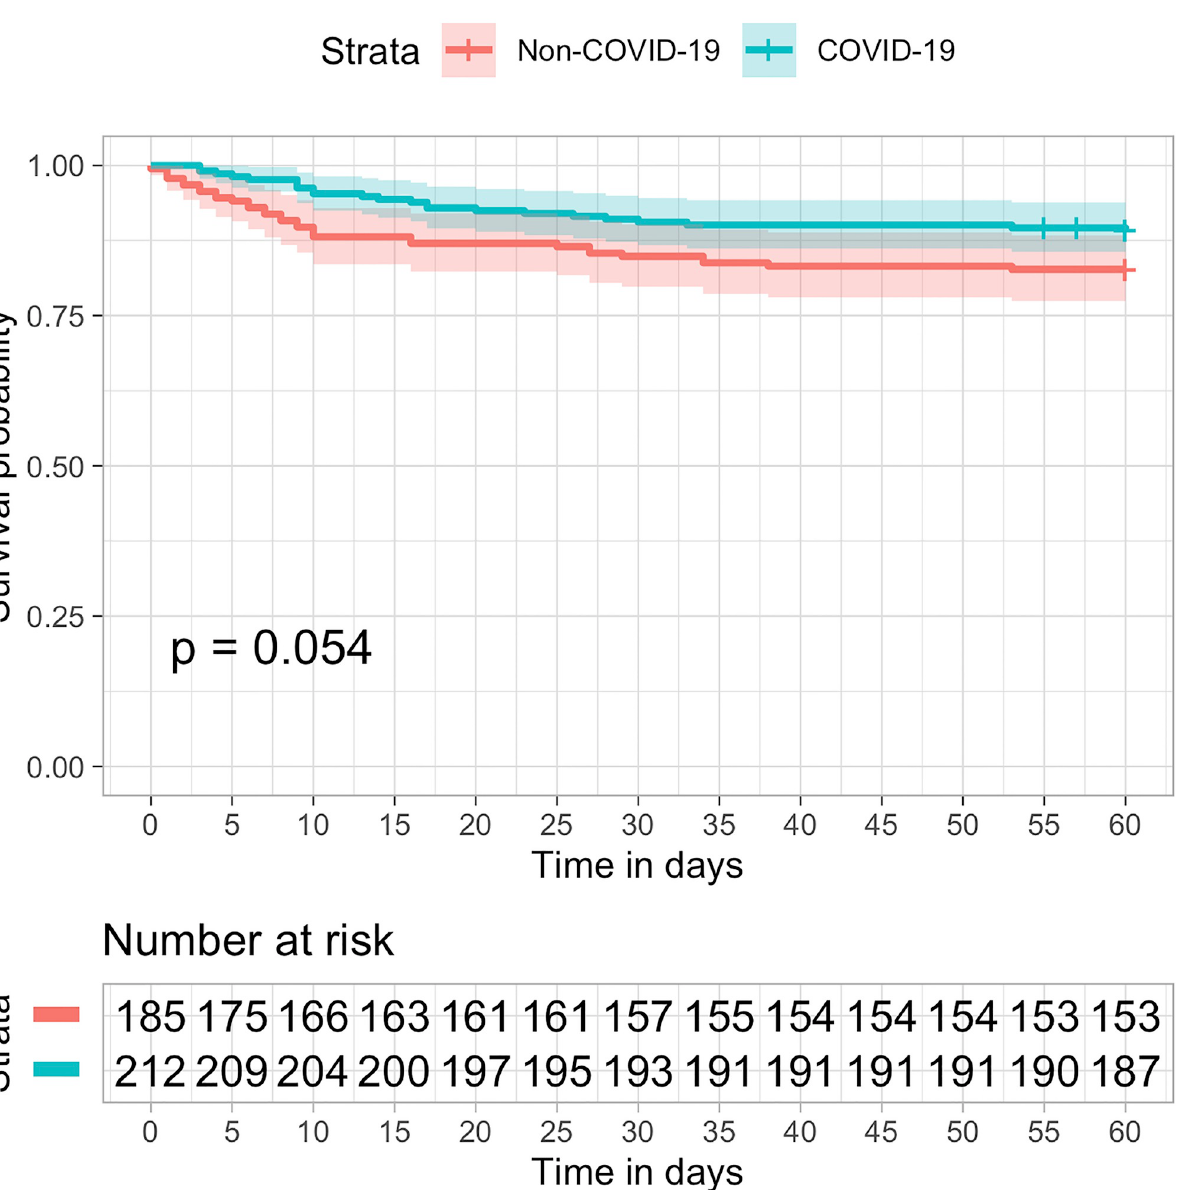
Fig 3. Kaplan–Meier estimates of all-cause survival rate up to 60 days. Symbols (tick marks) indicate censored data. Overall survival was not significant different in COVID-19 (blue) as compared to non-COVID patients (orange) in the previous year (logrank p =